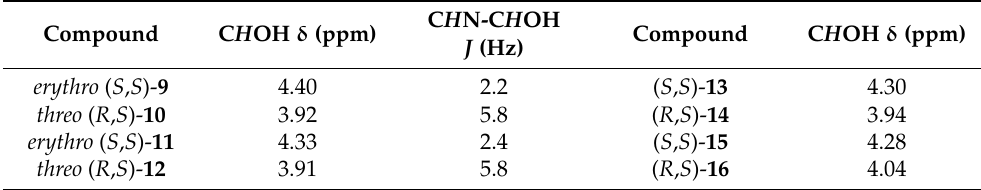
Table 2. Characteristic coupling constants and chemical shift values of diastereoisomers 9 – 16 .